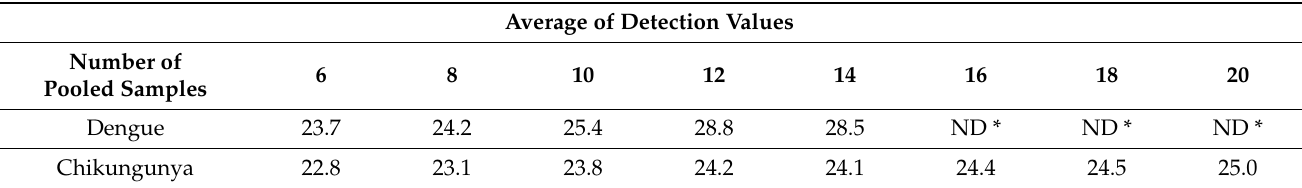
Table 1. Identification and detection values of the positive sample for DENV and CHIKV in different quantitative sample